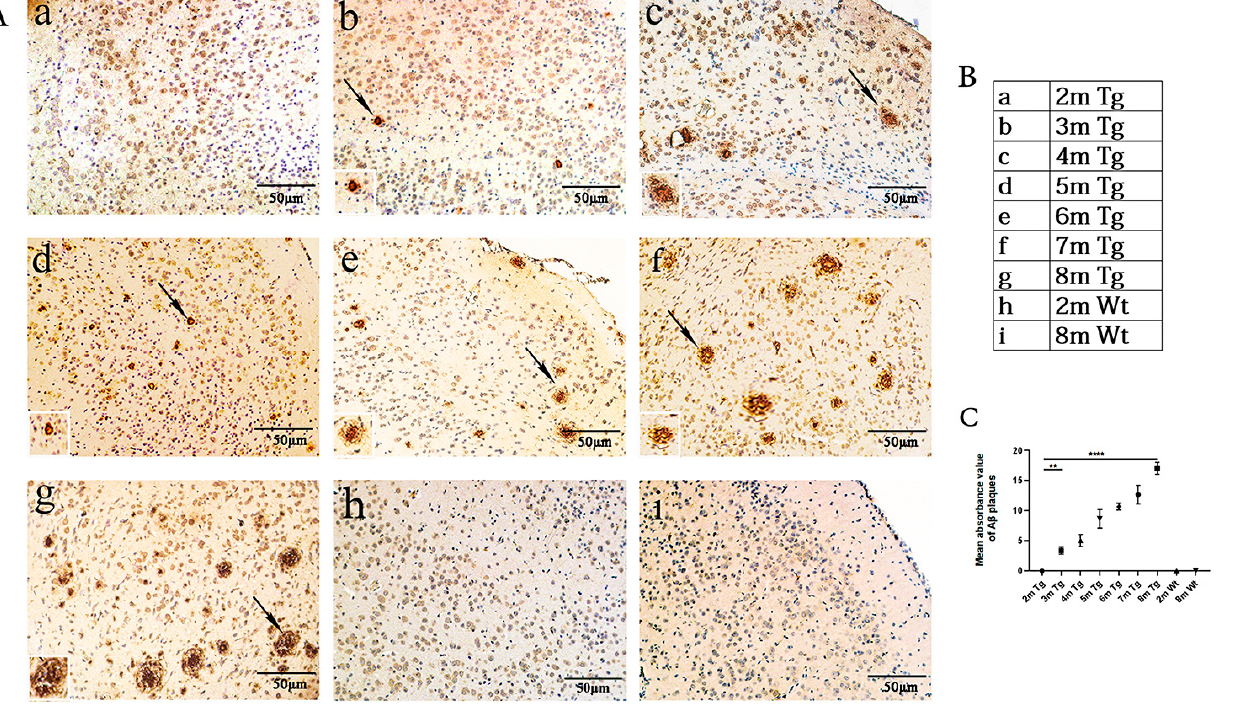
Figure 1. Age-related A β changes in the entorhinal cortexes of the APP/PS1 and Wt mice. ( Aa – g ) Entorhinal cortexes of APP/PS1 mice at 2–8 months (arrows show A β deposition). ( Ah – i ) Entorhinal cortexes of Wt mice at 2 and 8 months. ( B ) The details of the sample groups. ( C ) Quantitative statistical analysis of A β density. Scale bar = 50 µ m. All values are presented as the means ± SDs from three independent experiments. **** p < 0.0001 and ** p < 0.01. n = five mice per group.